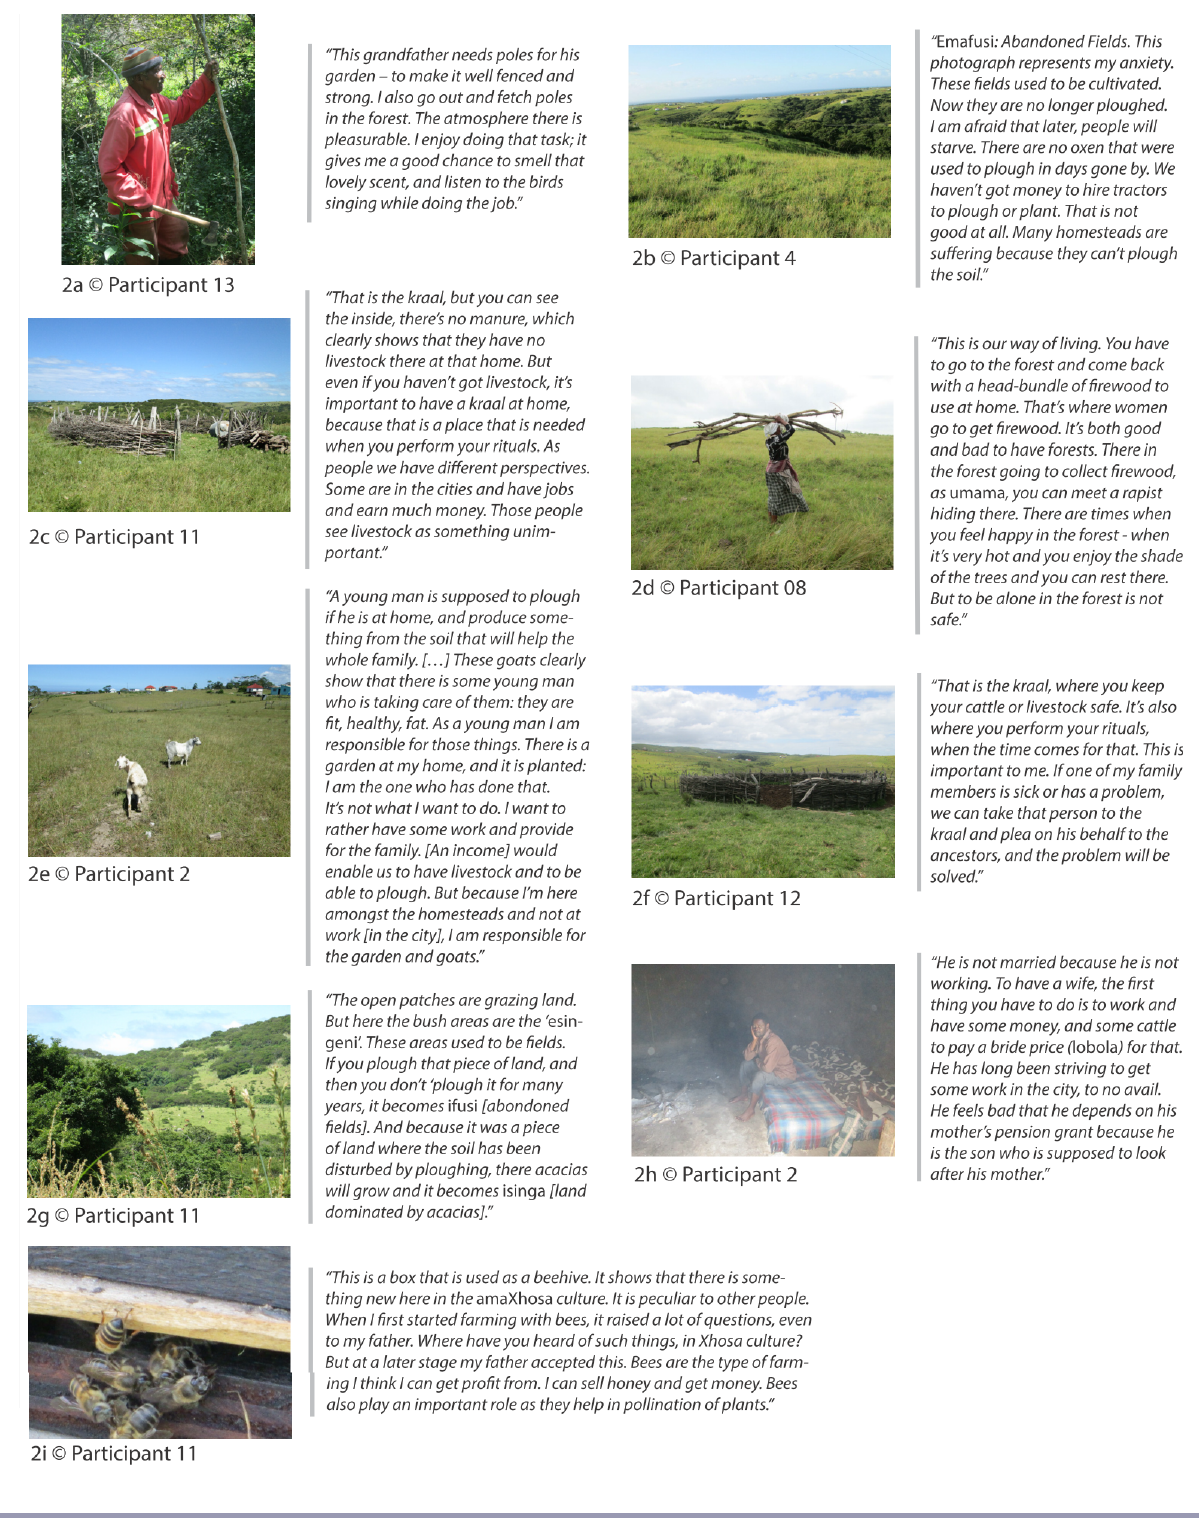
Fig. 2 . South Africa case study photographs and